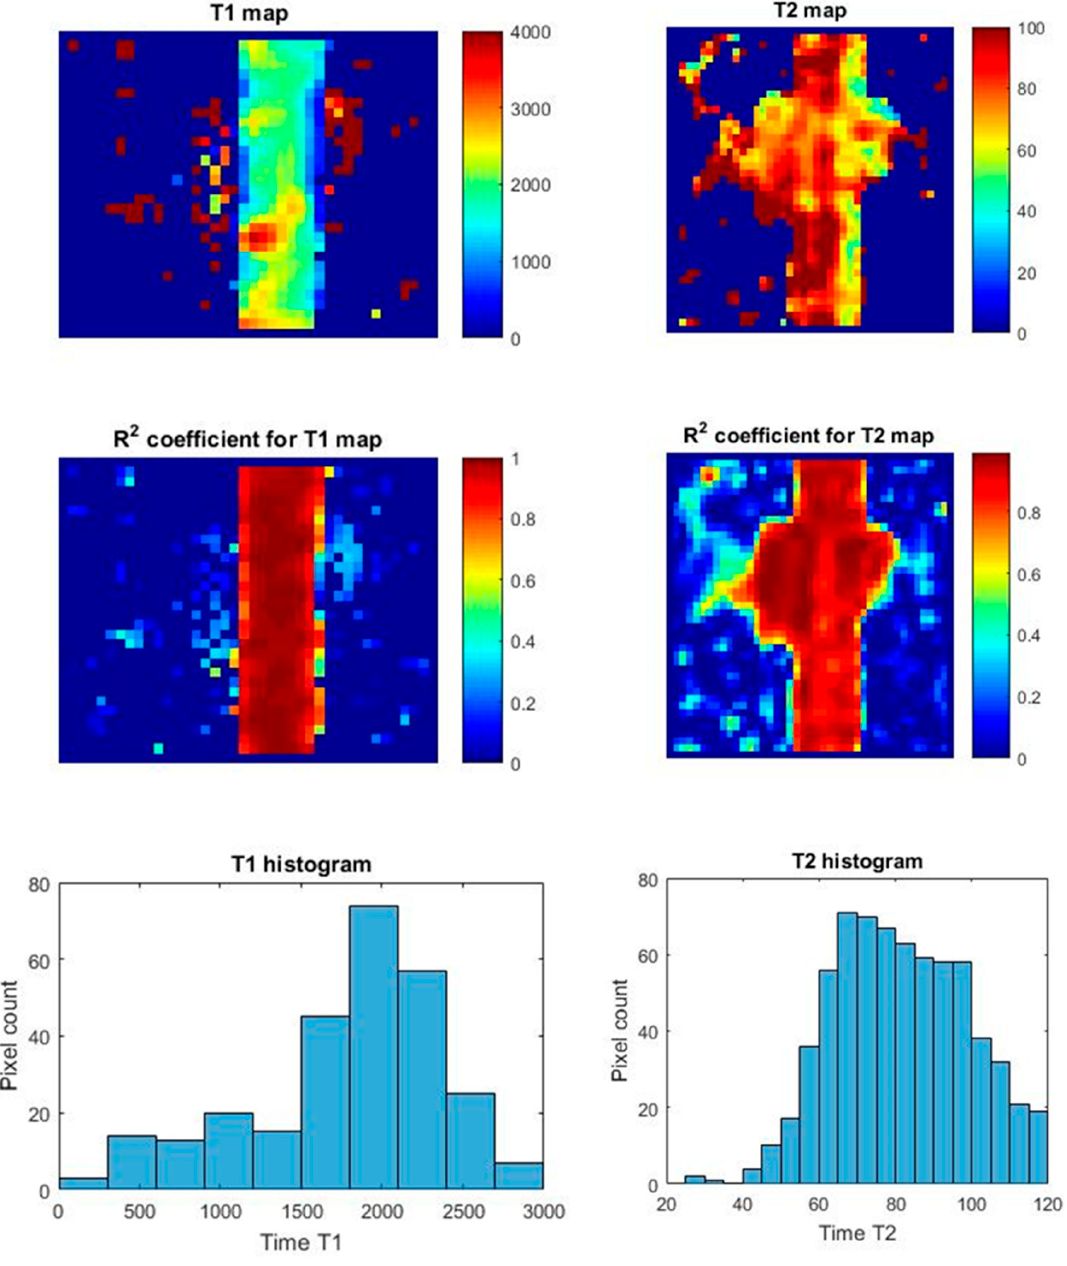
Figure 13. Maps of T 1 and T 2 relaxation times for the HTB-125 bioreactor +5 Thioether cross-linked dendrimer conjugate Trastuzumab derivative in the bioreactor, along with R 2 coefficient and histograms.